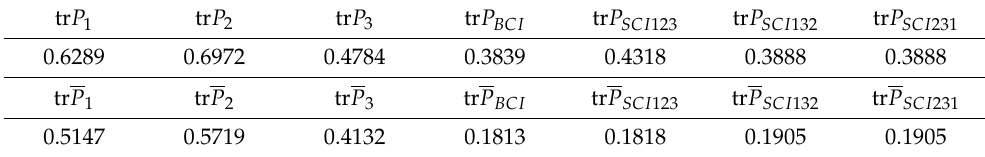
Table 3. The accuracy comparison of local and fused robust time-varying Kalman filters at t = 10. tr P 1 tr P